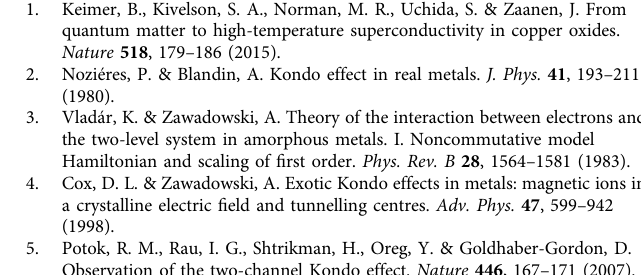
Fig. 4 Comparison of 2CK and 1CK resistivities. a Normalized Kondo resistivity 〈 ρ K 〉 / ρ K0 versus T / T K for RuO 2 NWs A – E manifests the 1CK scaling form (solid curve) for over three decades of reduced temperature. b 〈 ρ K 〉 / ρ K0 versus p T law between 0.39 and 21 K. For clarity, the experimental data points for RuO 2 NWs are plotted with small open symbols. c 〈 ρ K 〉 / ρ K0 of IrO 2 NW B1 ffiffiffiffiffiffiffiffiffiffiffi p T = T obeys a law between 0.66 and 22 K, distinctively deviating from the 1CK function. d Results for the resistivity of a diluted system of 2CK impurities K in a metallic host evaluated using a dynamical large- N limit (black symbols), which follows a ordinate is plotted in unit of half-bandwidth W = 4 eV (ref. 60